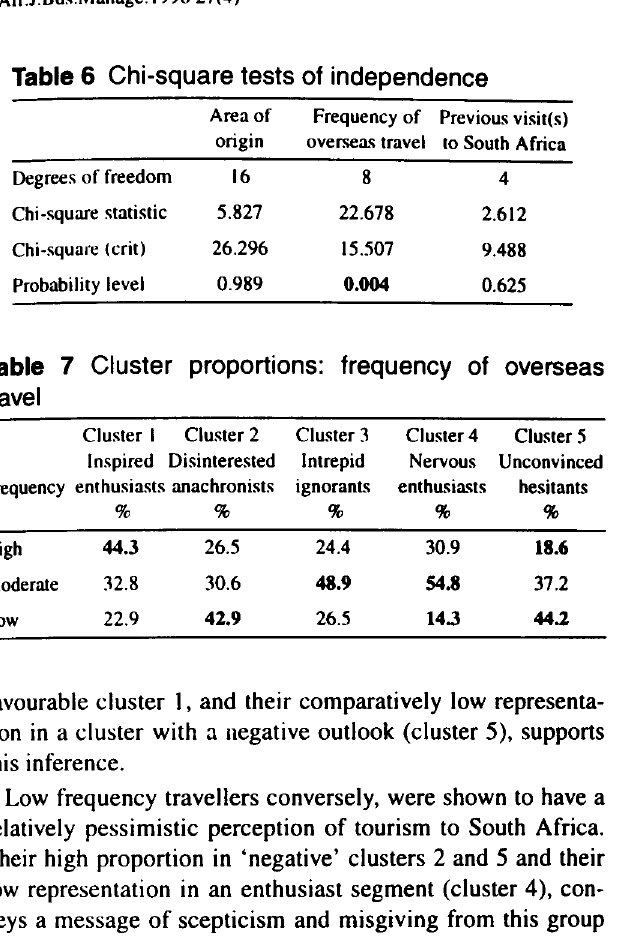
Table 7 Cluster proportions: frequency of overseas